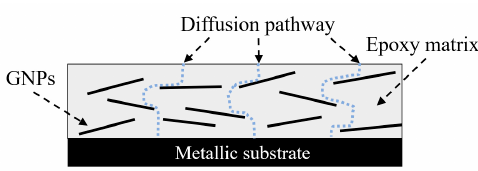
Figure 3. Bode plots in terms of ( a ) impedance and ( b ) phase angle for the test samples.